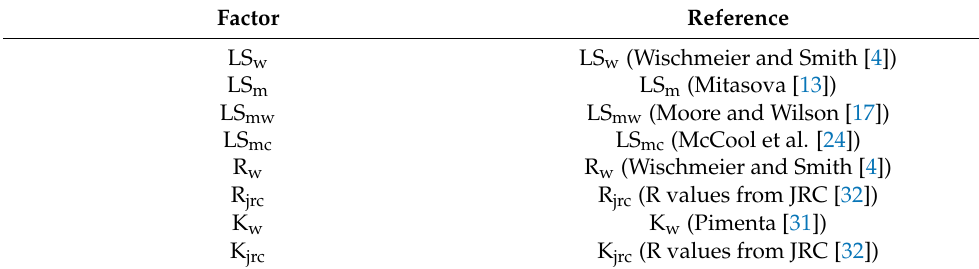
Table 1. Methodologies adapted for each factor (R, K and LS).